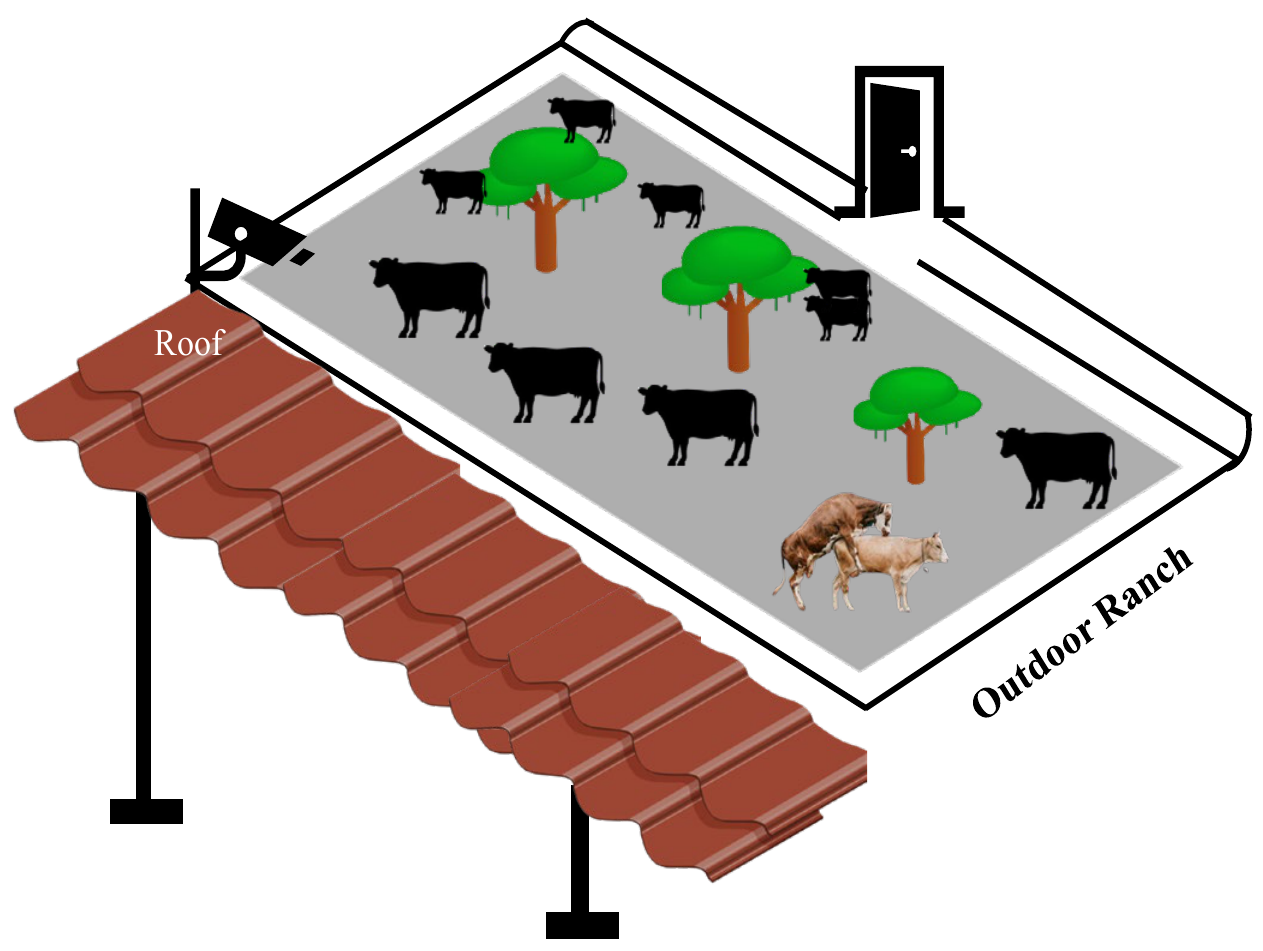
Figure 1. An illustration of the ranch layout.